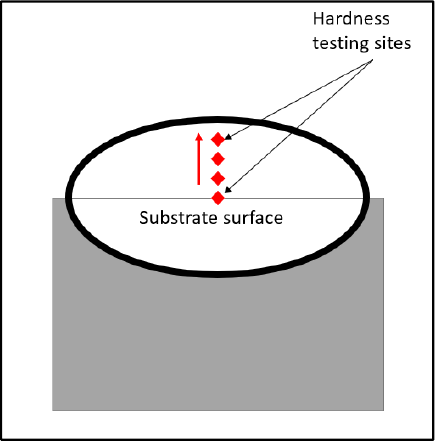
Figure 4. Diagram of hardness testing sites and test